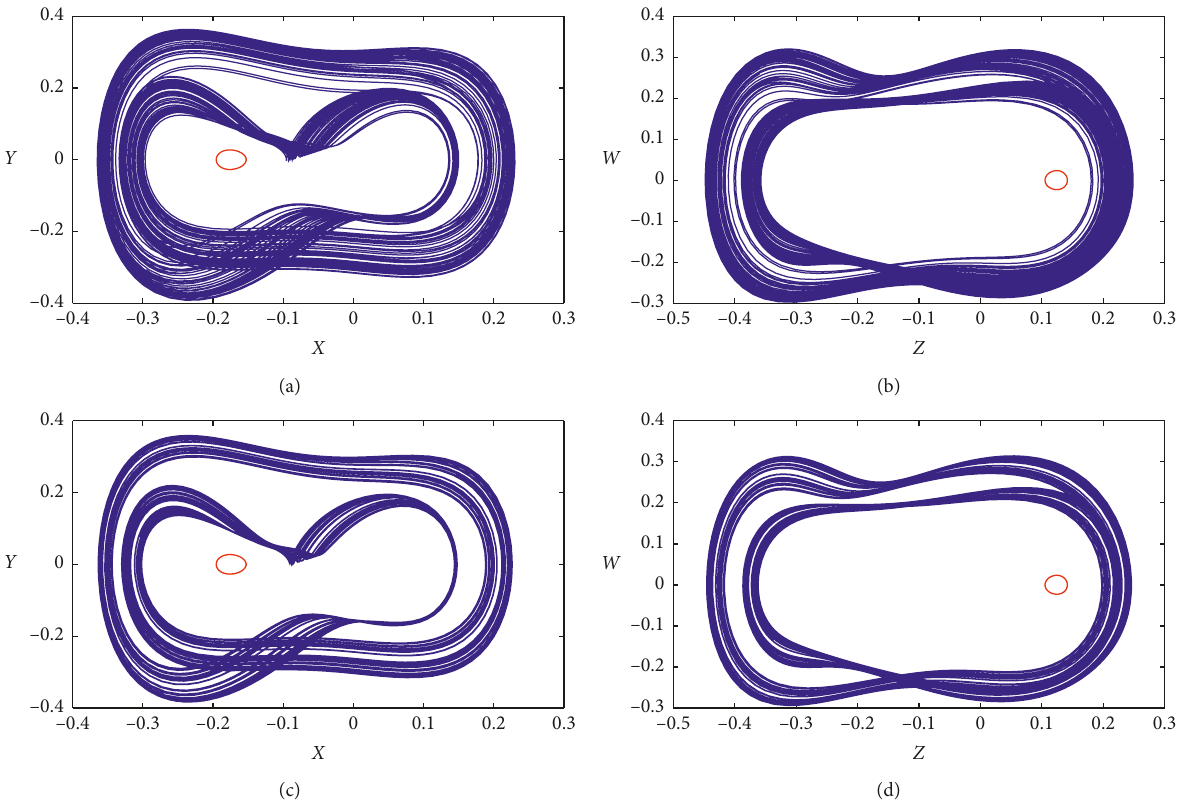
Figure 7: Coexisting attractors for different values of β : for β � 5 and initial conditions for (a, b) blue [ − 0.012, − 0.055, 0.009, − 0.125]; red [ − 0.13, 0, 0.09, 0]; for β � 7 and initial conditions for (c, d) blue [ − 0.09, 0.003, 0.13, 0.22]; red [ − 0.17, 0.02, 0.13, − 0.02].